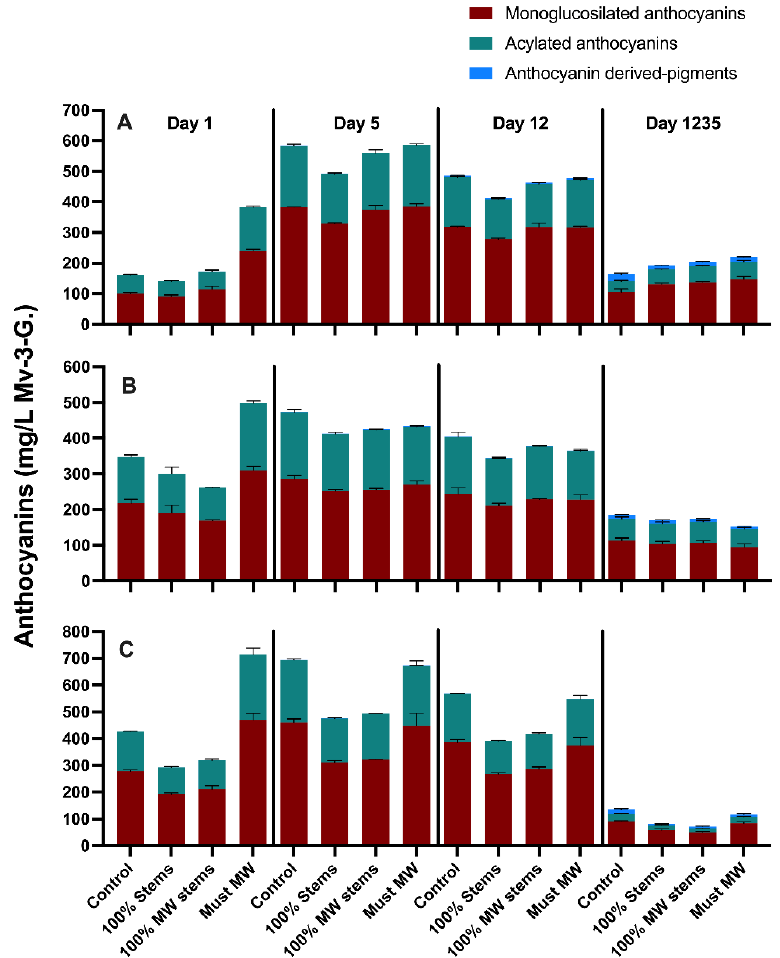
Figure 4. Evolution during winemaking and extended bottle aging (36 months) of monoglucosi- lated, acylated and anthocyanin-derived pigments. ( A ) Cabernet Sauvignon; ( B ) Merlot; ( C ) Syrah. Mv-3-G.: malvidin-3-glucoside equivalents.